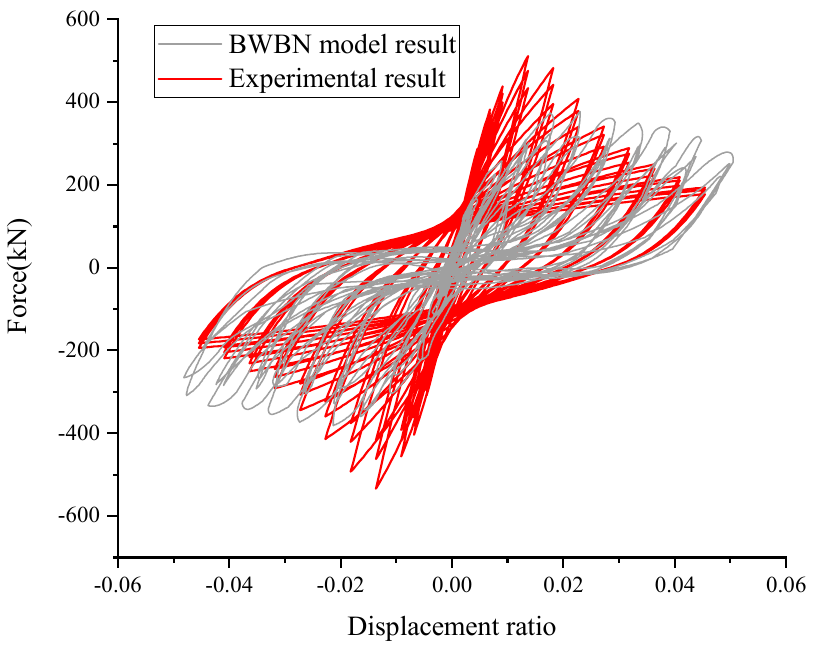
Figure 6. Comparison of the BWBN result with experimental result.